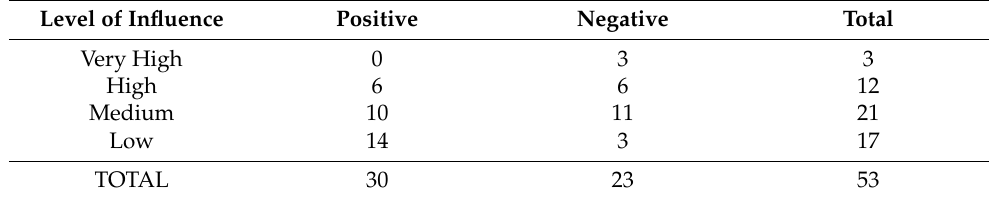
Table 8. Number of Categories by Level of Influence